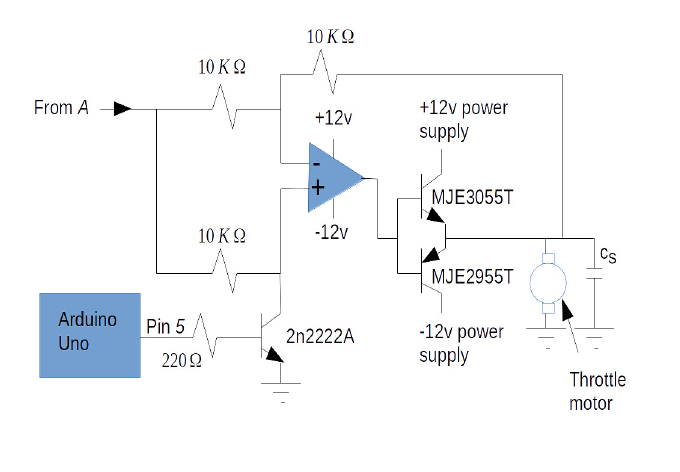
Figure 5. The electronic circuit to the switching mechanism unit. It receives information from the circuit in Figure 4. From this diagram, { K 1 , K 2 } = { 3.3, − 3.3 } . The operational amplifiers employed are in the LM 741 integrated circuit too. From this circuit, the 2 n 2222 A npn-transistor is employed to switch between the inverting and non-inverting op-amp